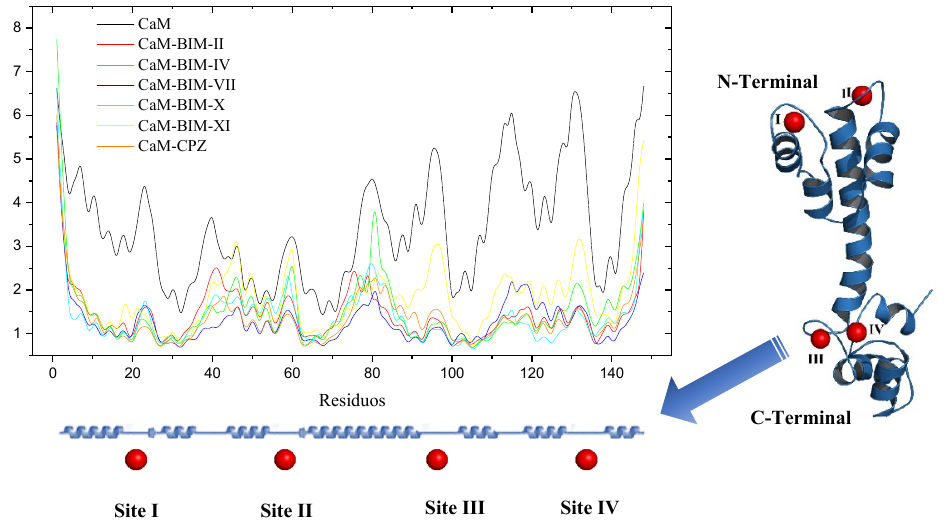
Figure 9. RMSF vs Time of CaM-BIS complexes and three-dimensional model of CaM highlighting calcium ion binding sites in red spheres .